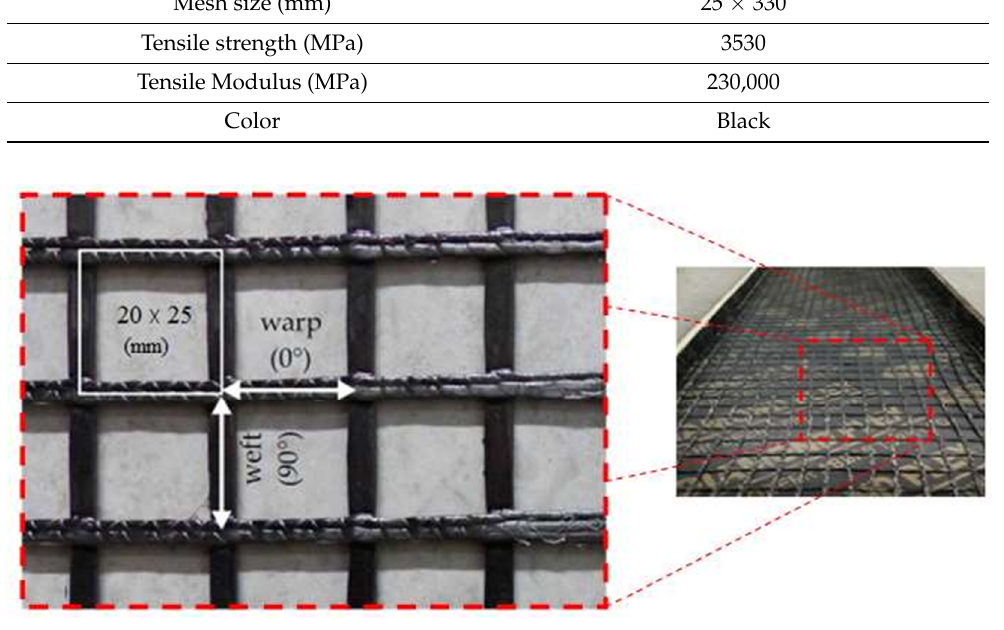
Figure 2. PAN (Polyacrylonitrile) textile. Table 4. Reinforcement details for the three slab